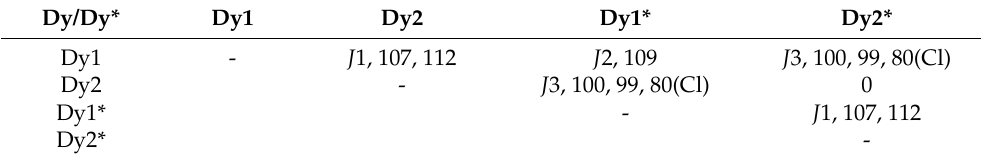
Table 1. Topological matrix for the exchange coupling with the bond angles Dy-O-Dy* in deg a .